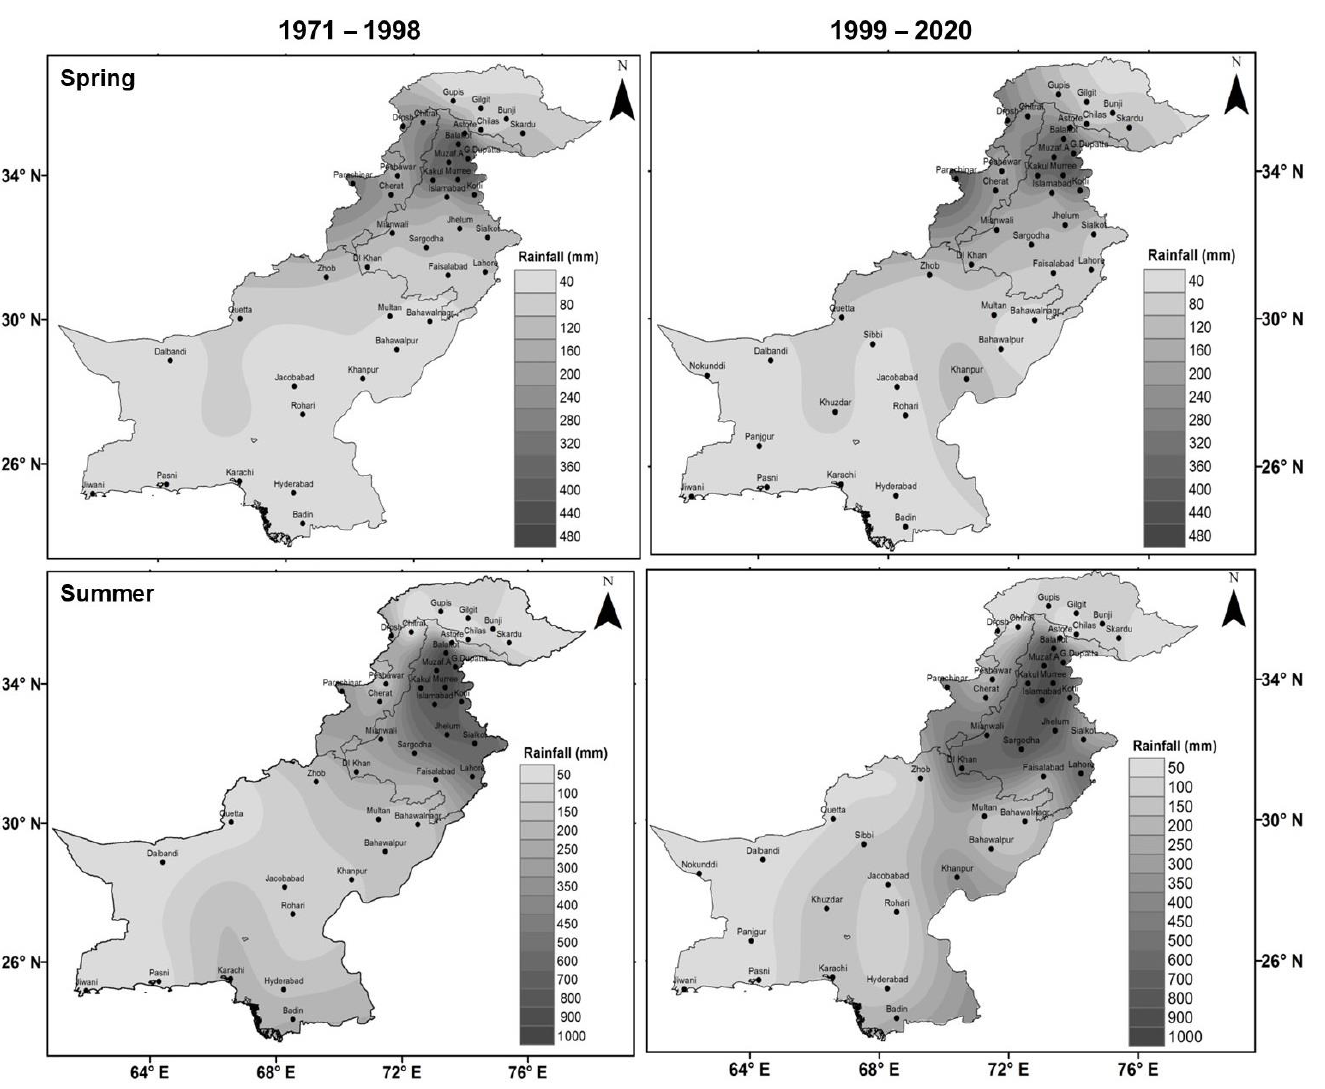
Figure 2. Climatology of seasonal precipitation in different regions of Pakistan.